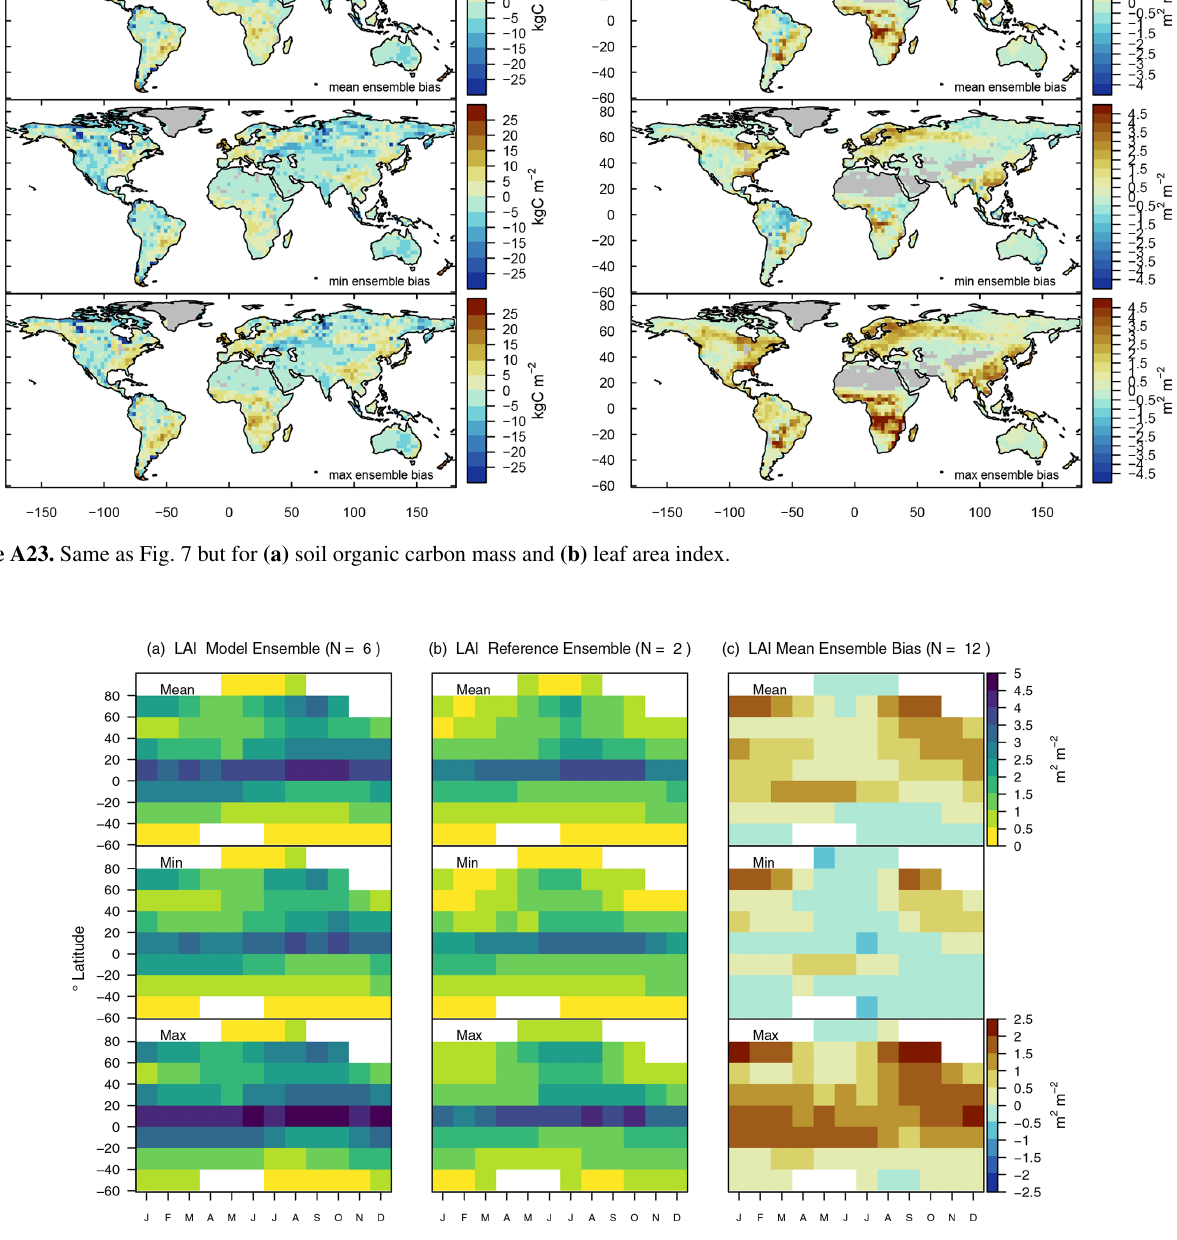
Figure A24. Same as in Fig. 8 but for leaf area